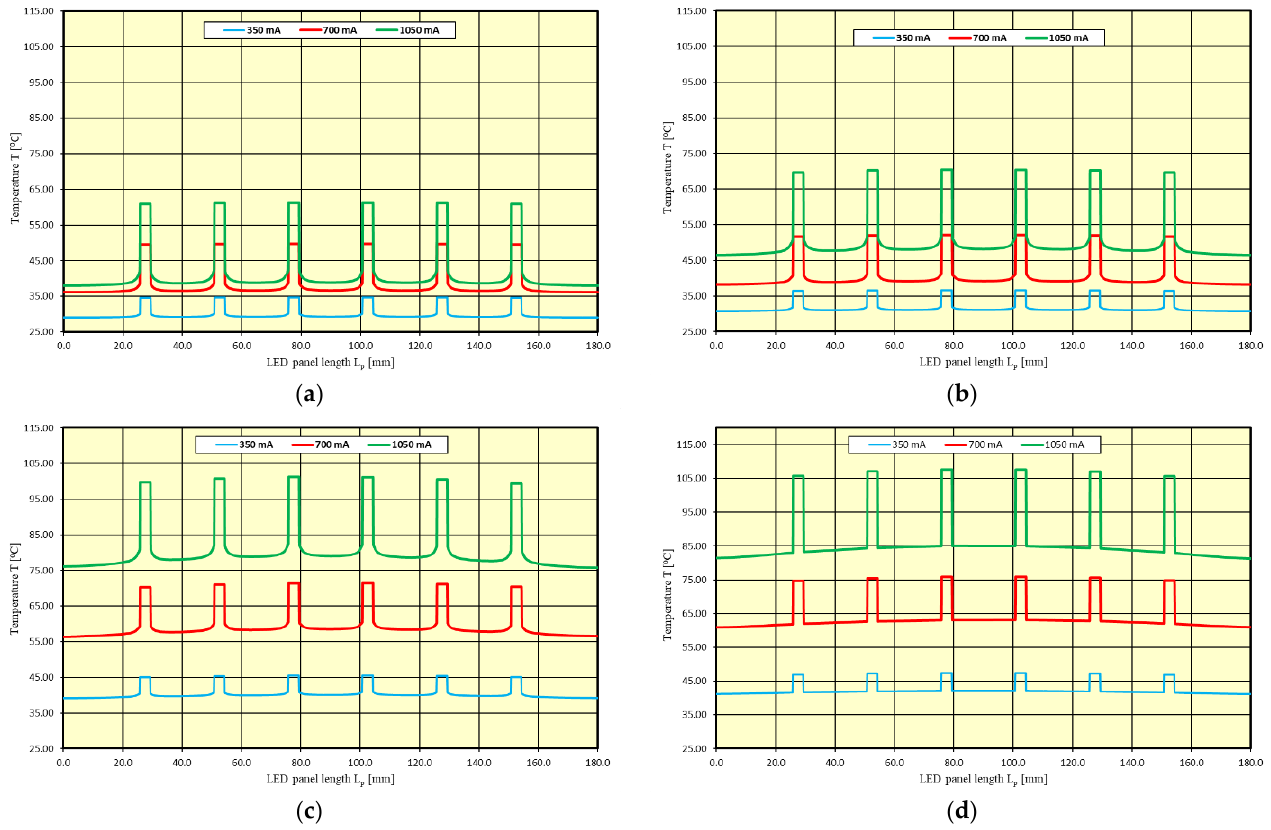
Figure 10. Temperature distribution for selected panels and three values of I F current along the axis with the maximum temperature T j of LEDs: ( a ) 1 × 6, ( b ) 3 × 6, ( c ) 5 × 6, ( d ) 6 × 6.